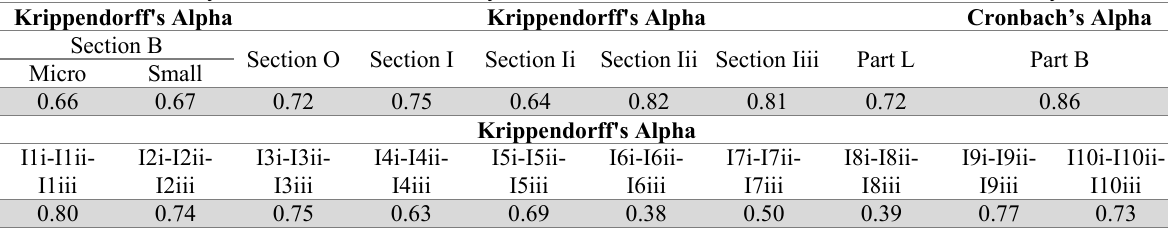
Interrater reliability and internal consistency assessment of the different sections of the